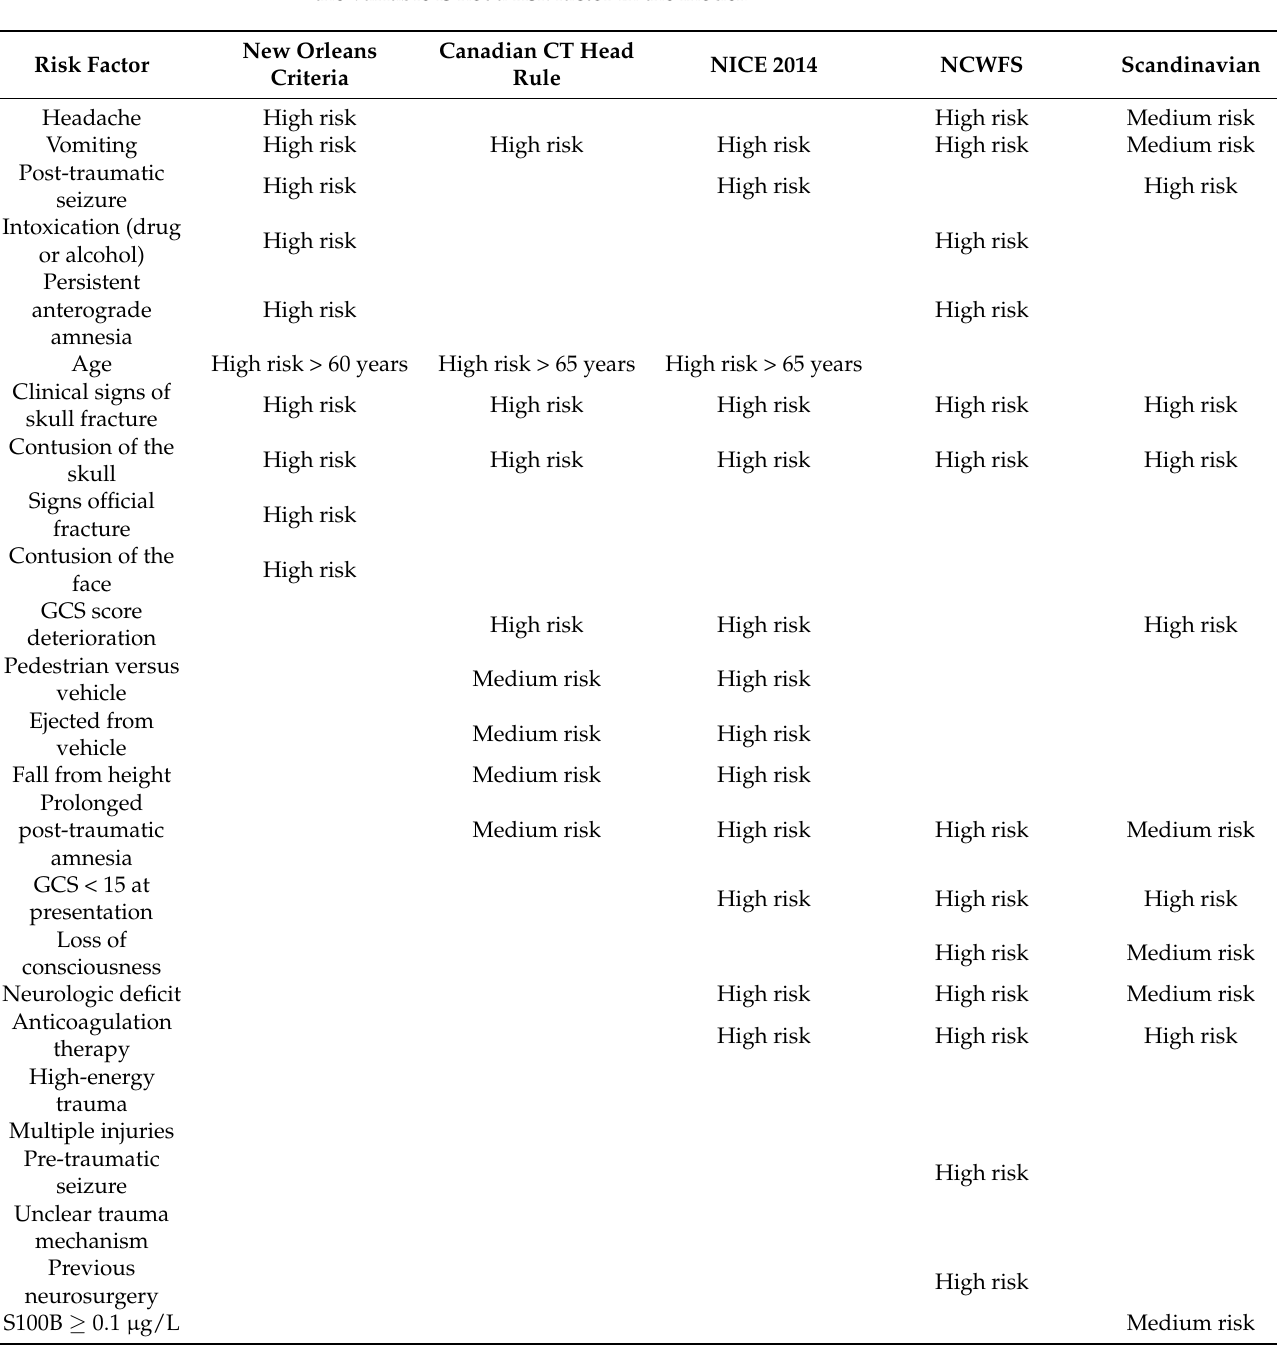
Table 1. Comparison between the already-in-use prediction rules for traumatic brain injury. NICE: National Institute for Health and Care Excellence; NCWFS: Neurotraumatology Committee of the World Federation of Neurosurgical Societies. High risk: risk factor is present in the prediction rule as a major criterion; medium risk: risk factor is present in the prediction rule as a minor criterion; blank: the variable is not a risk factor in the